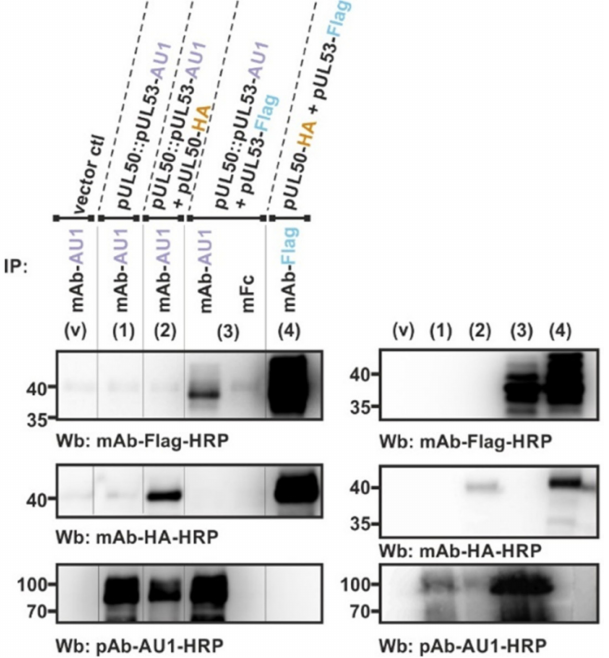
Figure 4. CoIP analysis demonstrating that a tagged fusion construct of the two HCMV core NEC proteins (pUL50::pUL53-AU1) is still capable of additional interactions. The indicated expression plasmids were used for the transient cotransfection of 293T cells and harvested at approx. 2 d p.t. for the preparation of total lysates. Expression levels of the individual proteins were monitored by the detection of lysate controls on Western blots (right panels: v, vector control; 1–4, coexpression protein samples, directly taken as the input for standard CoIP). The fusion protein alone (1) or combinations of twofold coexpression are indicated above the immunoblots (left panels: v, vector control; 2–4, coexpression lysates used for CoIP). Thereafter, the CoIP samples were washed and subsequently analyzed in a standard SDS-PAGE/Wb procedure, using the indicated antibodies for immunostaining (Wb). A nonreactive mouse Fc fragment (mFc, 3) was used as a negative control and the coexpression of pUL50-HA with pUL53-Flag (4) as a positive control.